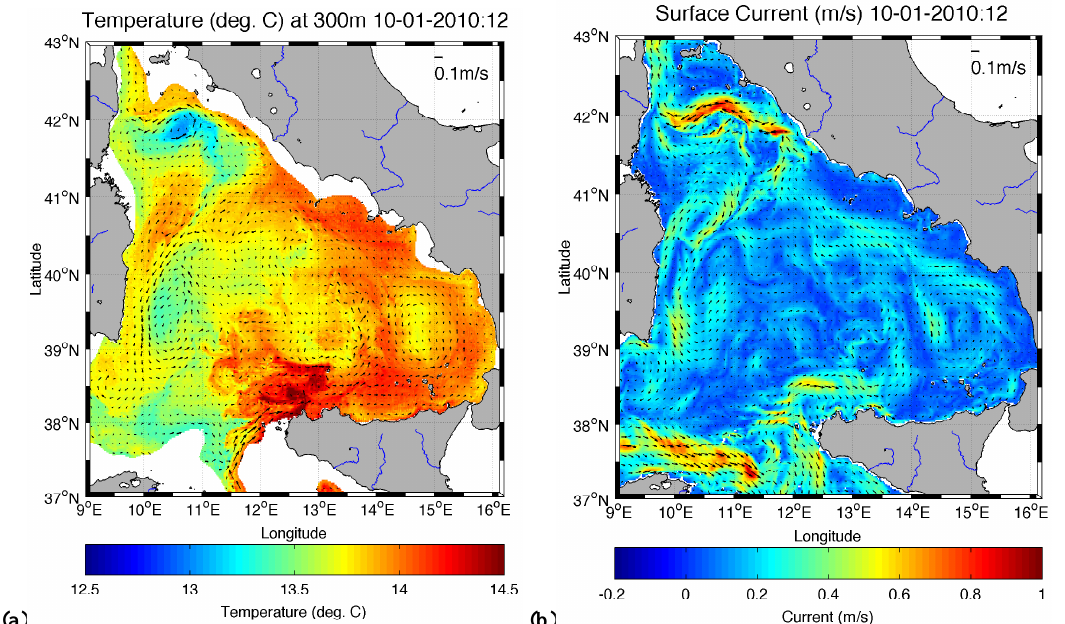
Fig. 4a. 10 January 2010, temperature at –300 m (temperature scale is expanded with respect to 5 m salinity maps). Fig. 3a. 10 January 2010, temperature at –5 m. Fig. 3b. 10 January 2010, salinity at –5 m.